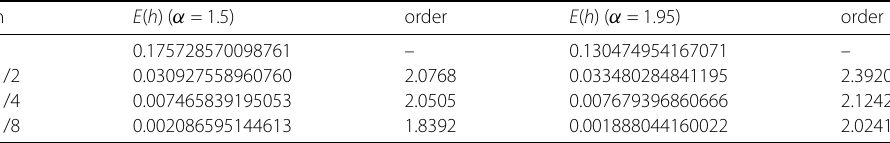
Table 4 The convergence order in spatial direction with α = 1.5,1.95, τ = 1/400 at time t = 1